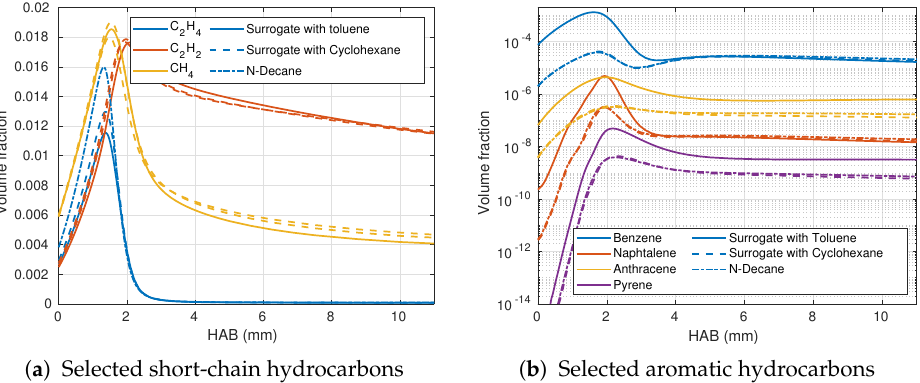
Figure 7. Comparison of numerically calculated species profiles for different mixture